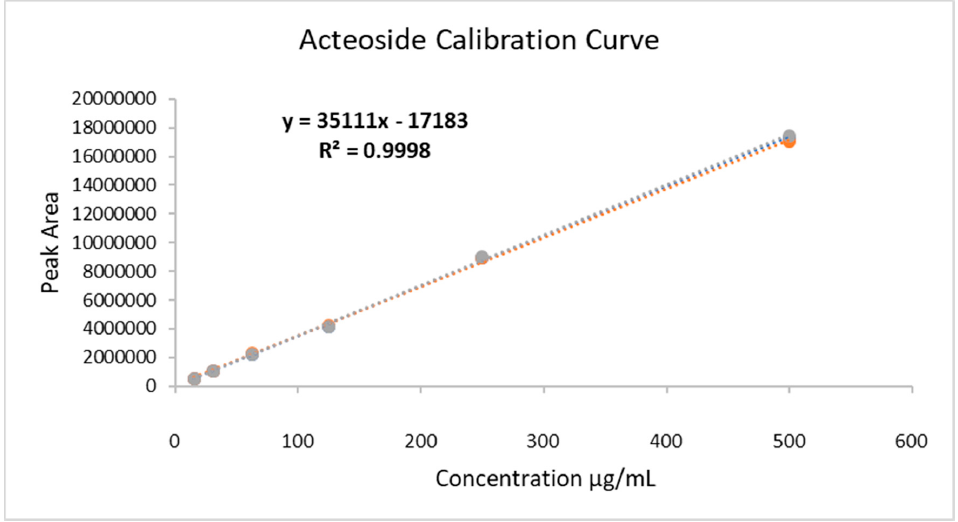
Figure 2. Calibration curve of standard acteoside for quantification of the analyte in hydroethanolic extracts of A. polystachya leaves. Concentration range: 15.25 to 500 µ g / mL (R 2 = 0.9995; R = 0.9998); LoD = 0.27 µ g / mL; LoQ = 0.89 µ g /